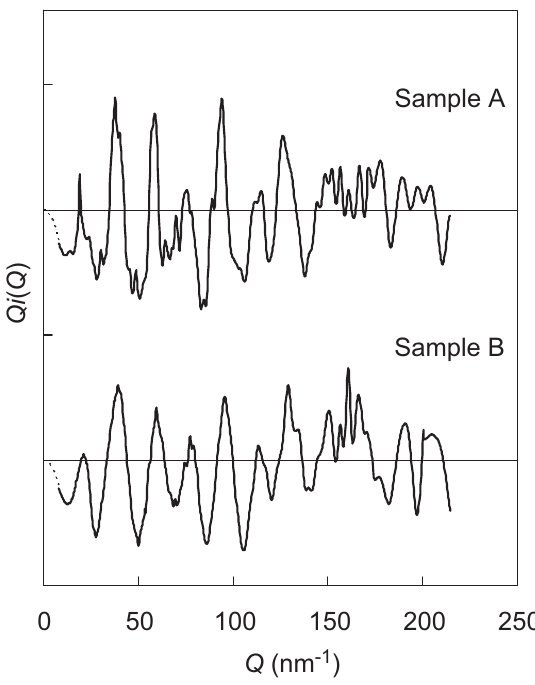
Figure 3. Interference functions, QŒS.Q/ (cid:2) 1(cid:6) of ZrSiO 4 gel sample A and B calculated from X-ray scattering pro- files measured by high energy X-ray diffraction ( E D 28 keV).